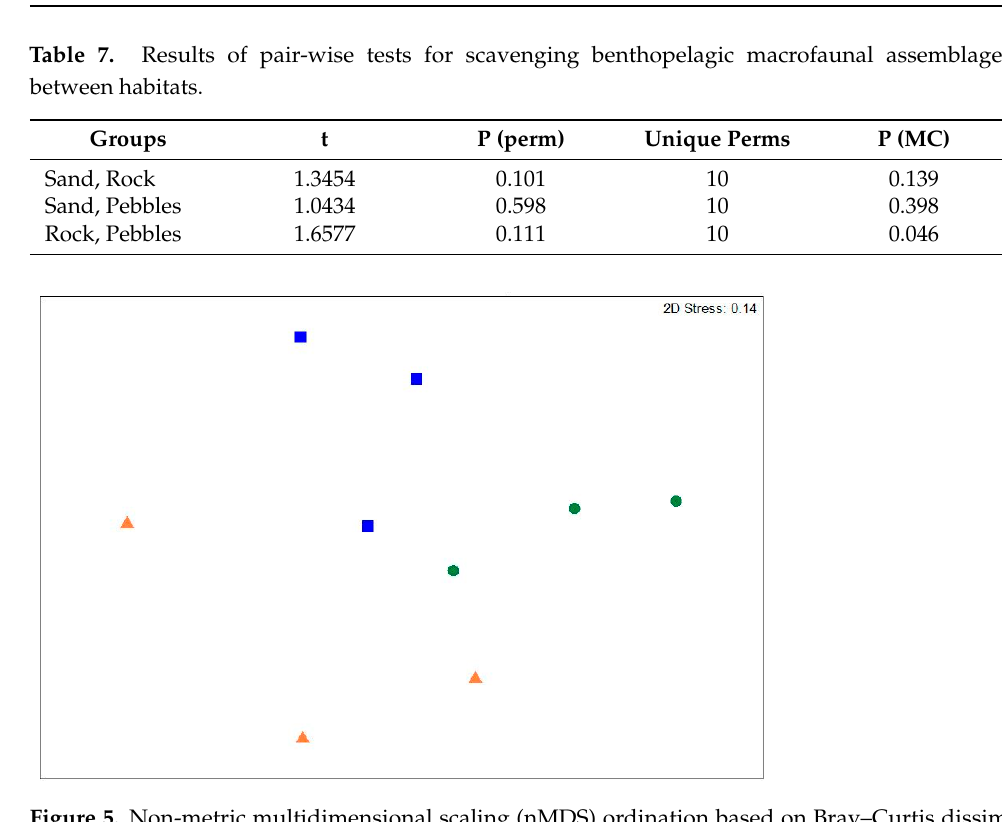
Figure 5. Non-metric multidimensional scaling (nMDS) ordination based on Bray–Curtis dissim- ilarity of centroids (calculated with the four replicates of scavenging benthopelagic macrofaunal assemblages in three different habitats). (a) Orange triangles: sand; (b) Green dots: rock; and (c) Blue squares: